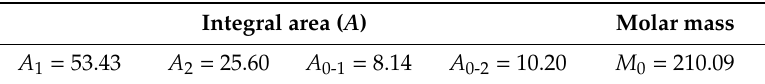
Table 1. Grafting rate